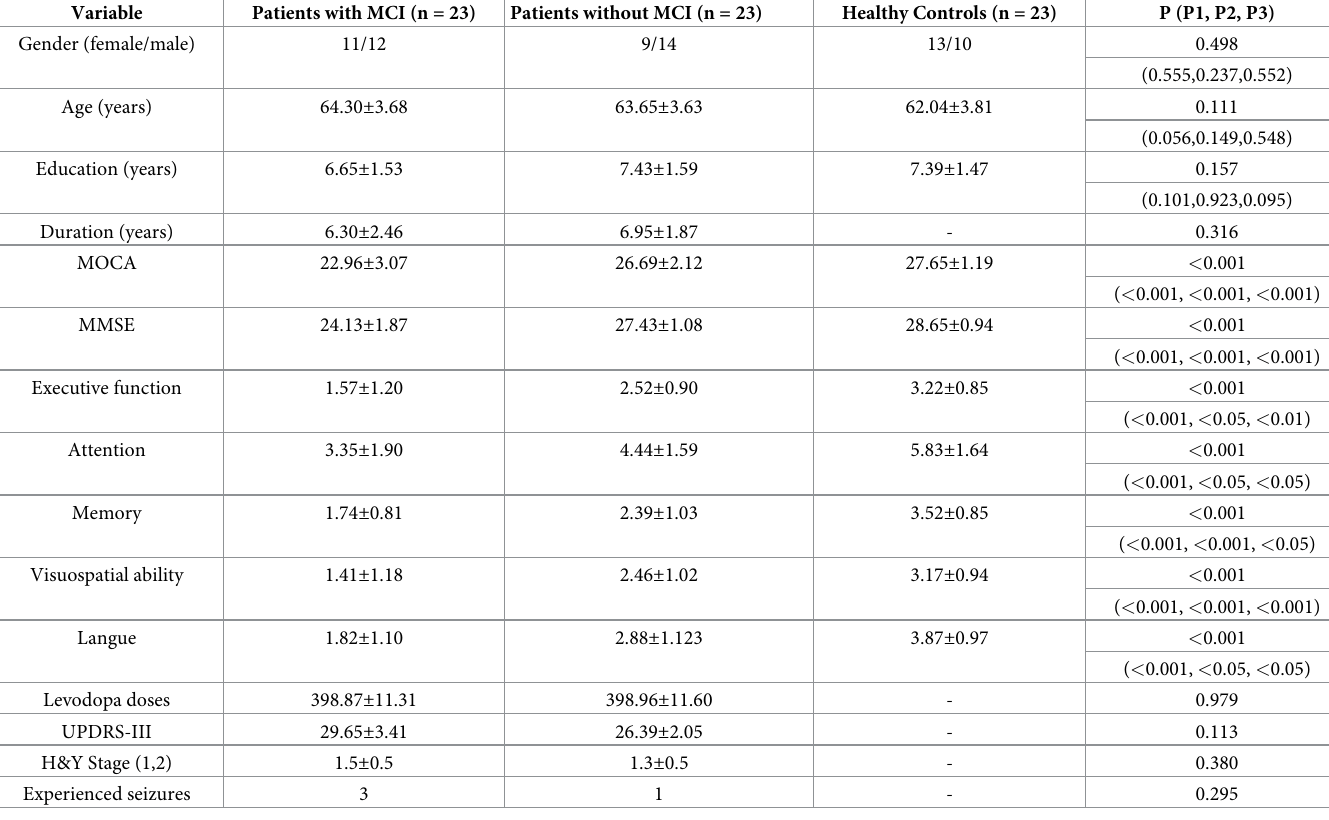
Table 1. Demographic, clinical, and neurocognitive characteristics among the three groups. Variable Patients with MCI (n = 23) Patients without MCI (n = 23) Healthy Controls (n = 23) P (P1, P2, P3) 11/12 9/14